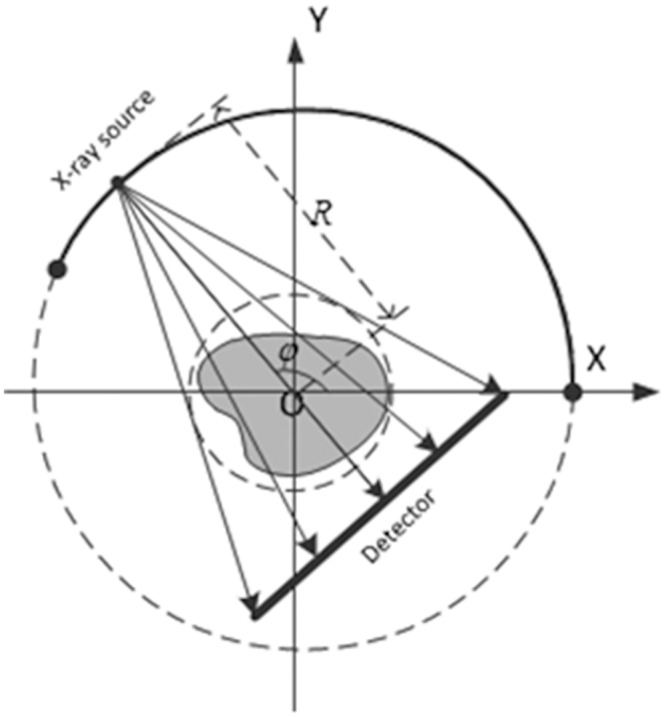
Scanning geometry configuration for circular and limited-angle fan-beam CT.